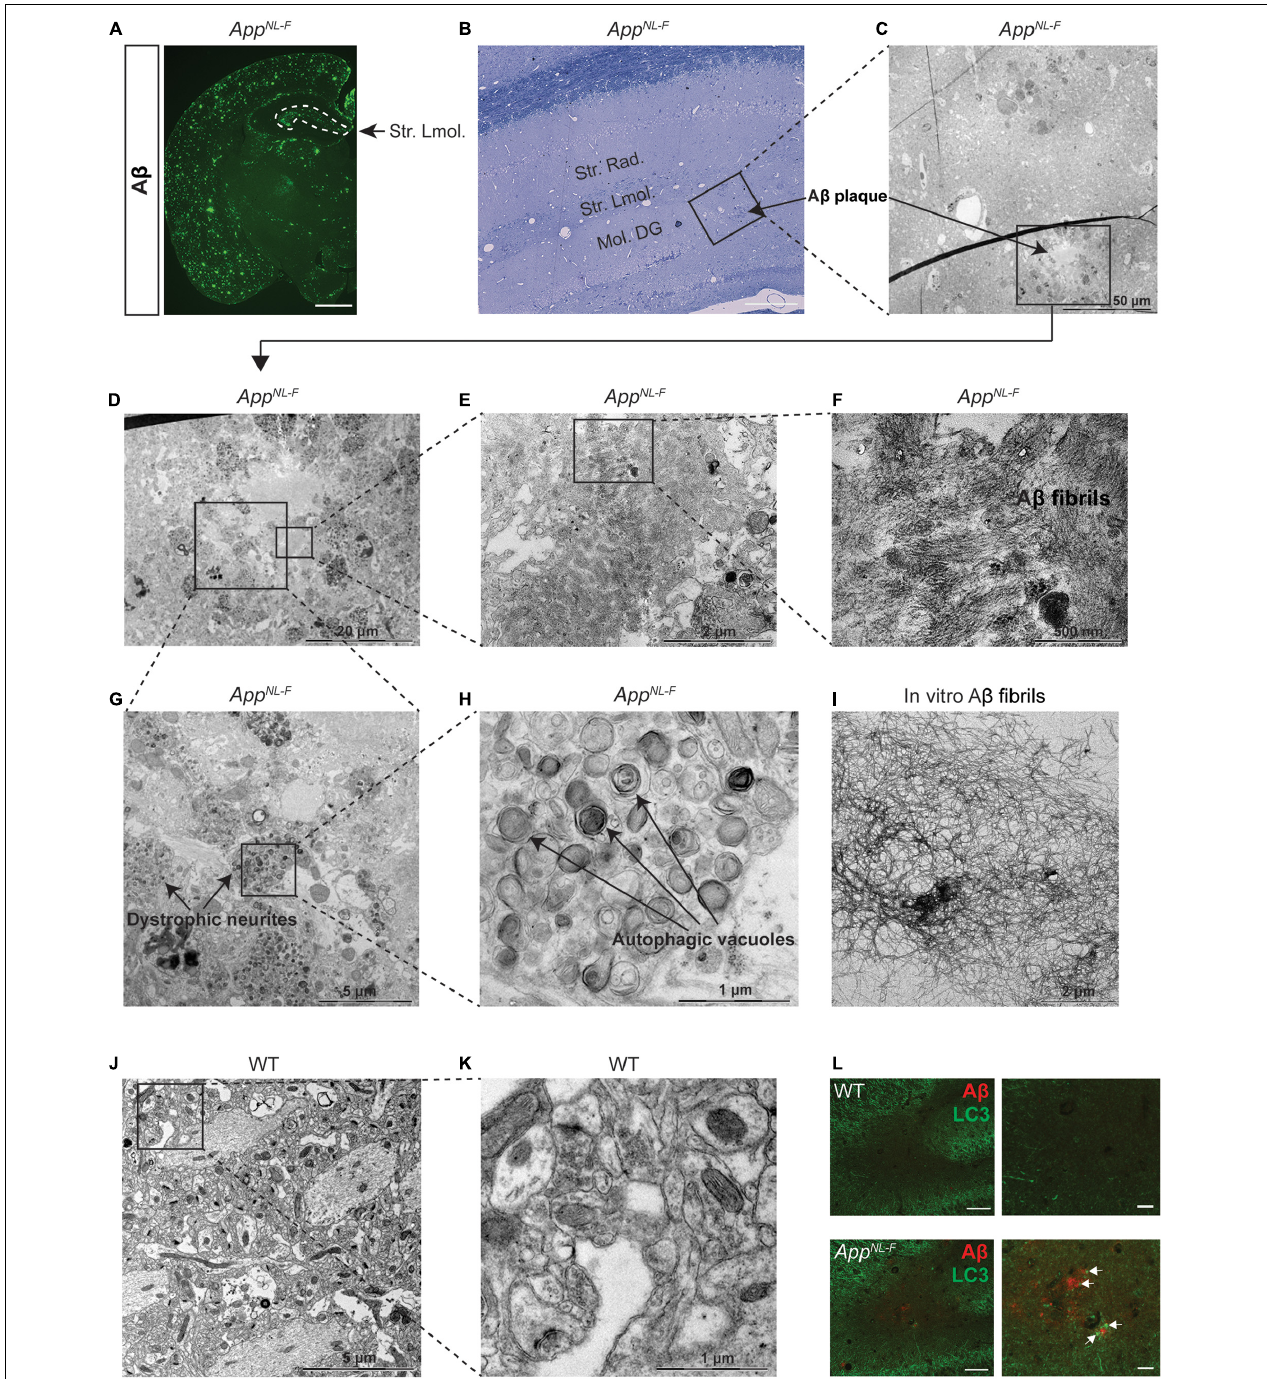
FIGURE 4 | Autophagic vacuole accumulation in dystrophic neurites in aged App NL − F mice. (A) Immunostaining of A β plaques in 24-month-old App NL − F mouse brains. Scale bars represent 1,000 µ m. (B) Toluidine blue staining of 24-month-old App NL − F mouse hippocampus. Scale bars represent 100 µ m. The area labeled in black box was imaged under electron microscopy (EM) and shown in (C) . The area in black box in (C) showing A β plaques was zoomed in (D) . The area in black boxes in (D) were further zoomed in and shown in (E,G) , showing A β plaques and dystrophic neurites, respectively. A β plaques and fibrils were shown in (F) and the autophagic vacuoles were shown by higher magnification in (H) . (I) A β fibrils formed in vitro and imaged by EM. (J) The EM image from 24-month-old WT mouse hippocampus and the area in the black box was zoomed in (K) . Scale bars for EM images were presented in the images. (L) Double immunostaining of A β and LC3 in the hippocampus in 24-month-old WT and App NL − F mice. Scale bars represent 100 µ m. Str. Lmol., stratum lacunosum-moleculare; Str.Rad., stratum radiatum; Mol. DG, moleculare dentate gyrus.